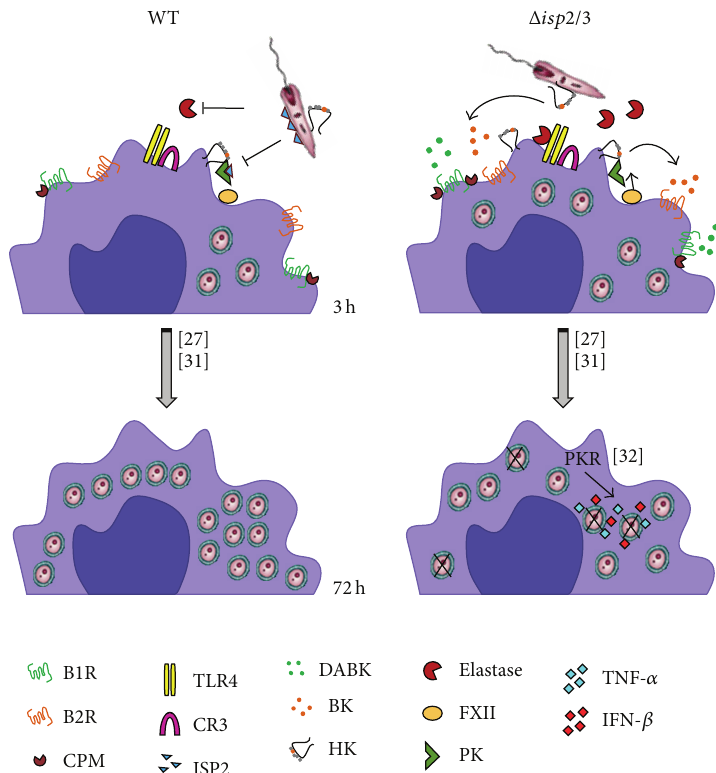
Figure 5: Scheme shows how ISP-2 limits the kinin-releasing activity of surface S 1 A-proteases of macrophages. As an extension of recently published studies [27, 31, 32], here we propose that the proinflammatory phenotype of the Δ𝑖𝑠𝑝2/3 mutant (right side of scheme) is due to increased pericellular release of kinins mediated by NE and/or contact phase serine proteases (FXIIa/PKa). In the absence of ISP-2, the “eat me signal” of kininogen tethered on L. major mutants might be inactivated by S 1 A-family proteases. In addition, the released kinin peptides fuel phagocytosis and microbicidal function of macrophages via activation of B 2 R and B 1 R, a subtype of GPCR upregulated in inflamed